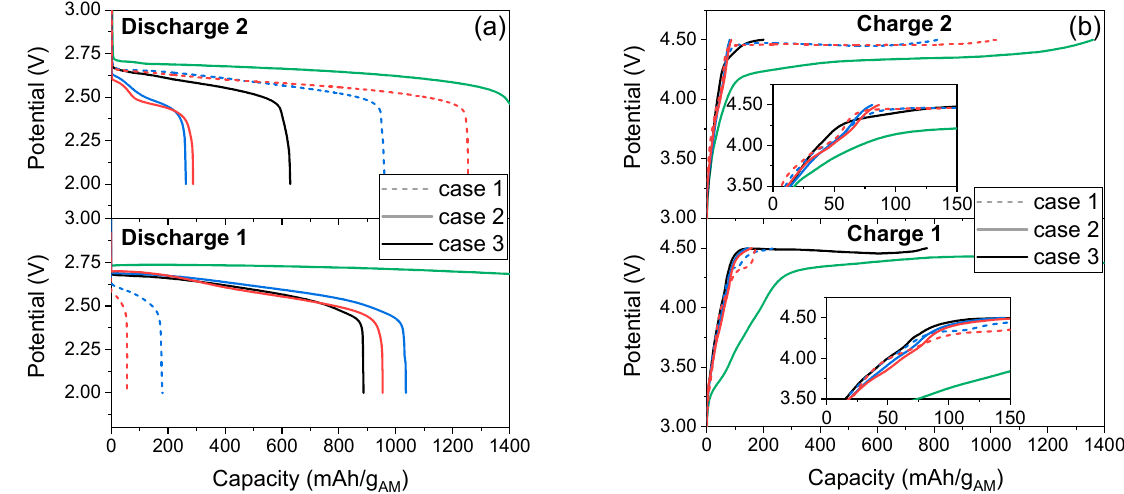
Figure 7. Comparison of ( a ) discharge and ( b ) charge potentials of cycle 1 and cycle 2 for Li-O 2 batteries with H-MIL-53 (blue), MW-MIL-53(red) and Super P carbon (green) electrodes.